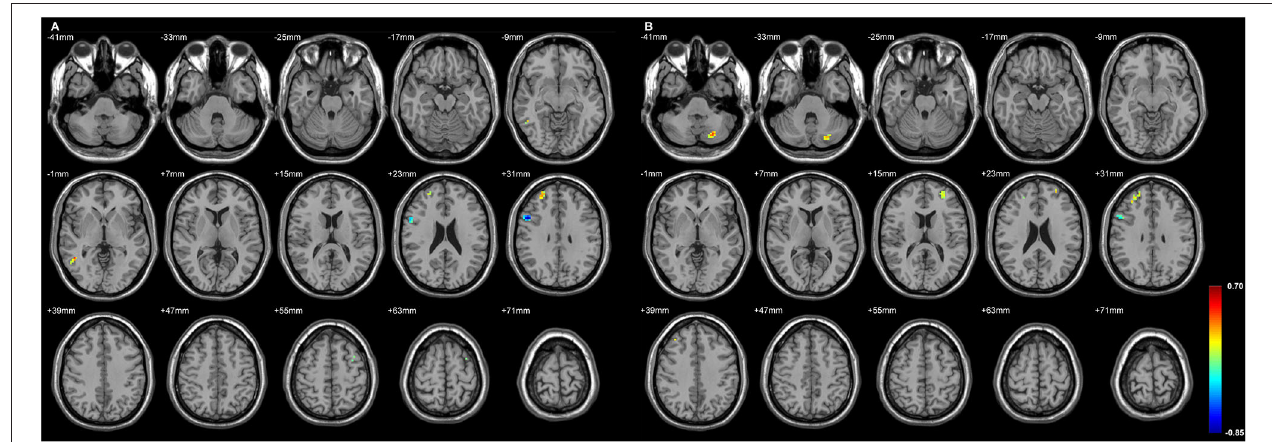
FIGURE 5 | The regions with their GMD related to the (A) left LD-CL and the (B) right AV-LD-LP-VA-Vamc-CeM-MV(Re)-MDl-L-Sg volume changes in R-TLE. Both positive and negative relationships are depicted, and are mostly located in the right frontal lobe. GMD of the right inferior frontal gyrus was negatively related to each side of thalamic subfield volume changes in R-TLE. Differences with a p < 0.01 were considered significant (with a threshold p < 0.01 and a minimum cluster size = 354 voxels, as determined by the AlphaSim